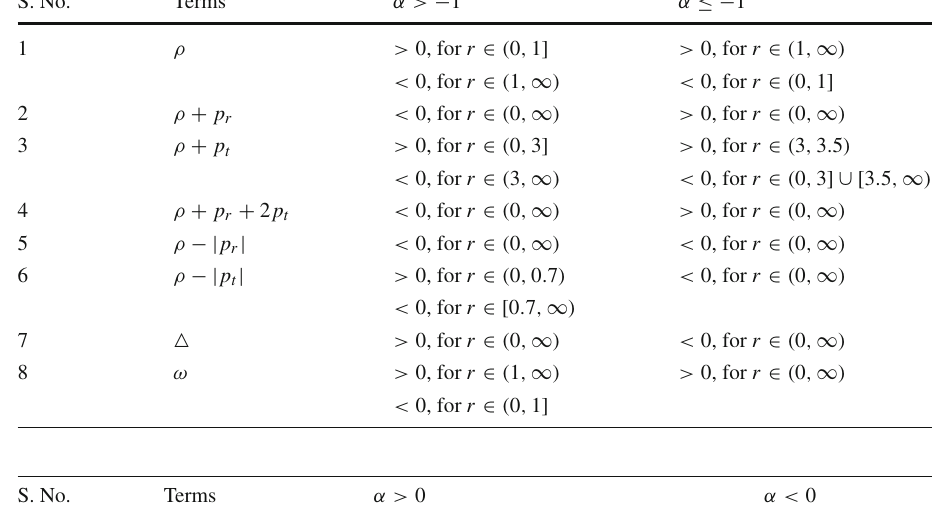
Table 10 Summary of